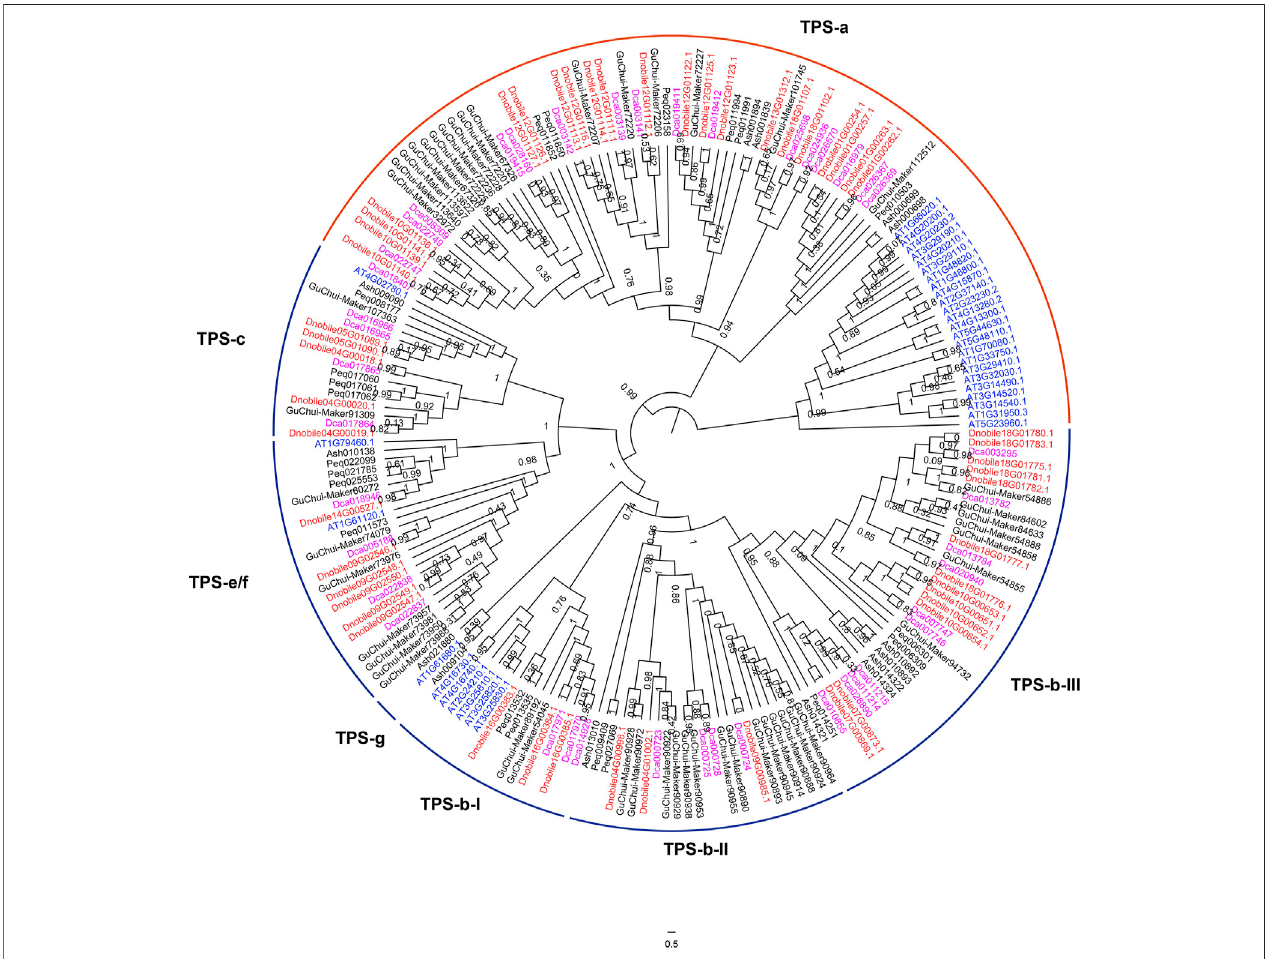
FIGURE 9 | Analysis of terpene synthase (TPS) genes in Dendrobium nobile . Phylogenetic analysis of TPS genes in D. nobile , Dendrobium chrysotoxum , Dendrobium catenatum , Apostasia shenzhenica , Arabidopsis thaliana , and Phalaenopsis equestris. Dnobile, D. nobile ; Ash, A. shenzhenica ; Guchui-Maker, D. chrysotoxum ; Dca, D. catenatum ; Peq, P. equestris ; AT, A. thaliana